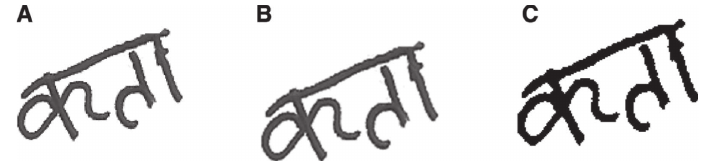
Figure 4: Three Different Forms of an Input Word Image. (A) Original, (B) gray-scale, and (C)